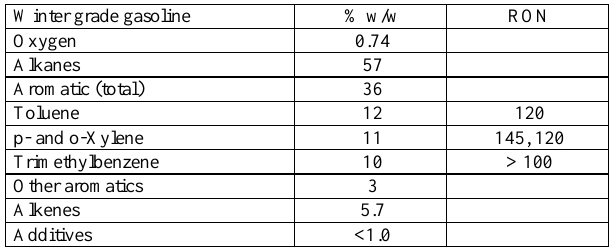
Table 2. Properties and composition of gasoline used as received from the distributed company Winter grade gasoline